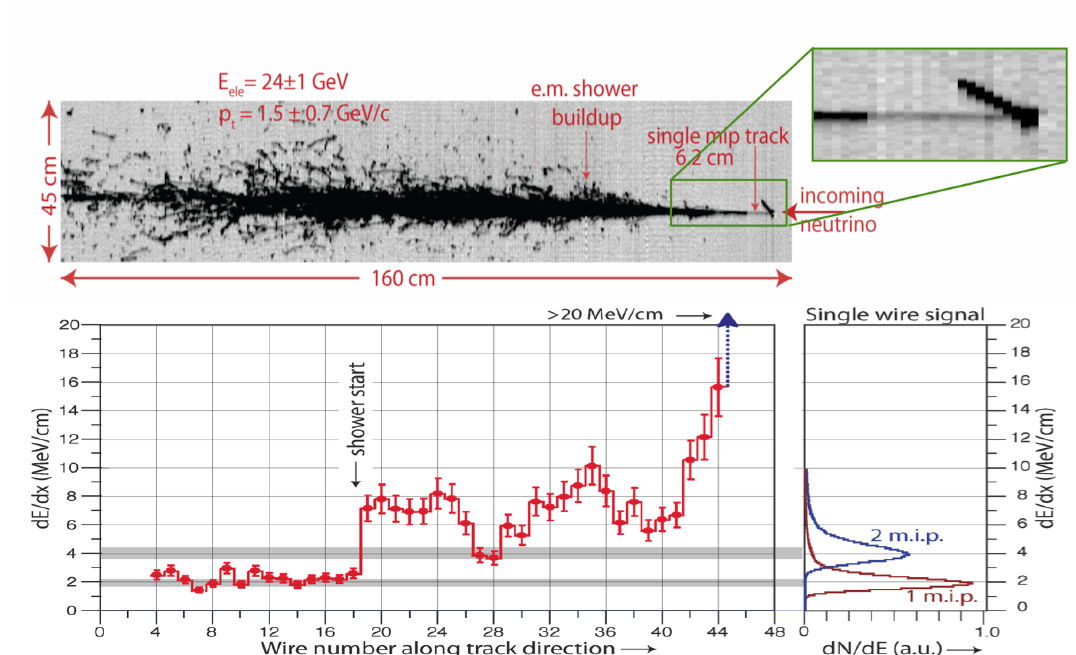
Figure 1. ν e CC CNGS event in the 2D Collection view of ICARUS-T600 ( top ) with the corresponding evolution of ionization density, dE/dx, in the first wires with the marked shower onset ( bottom ). The expected dE/dx signals for 1 and 2 minimum ionizing particle (m.i.p.) are also shown